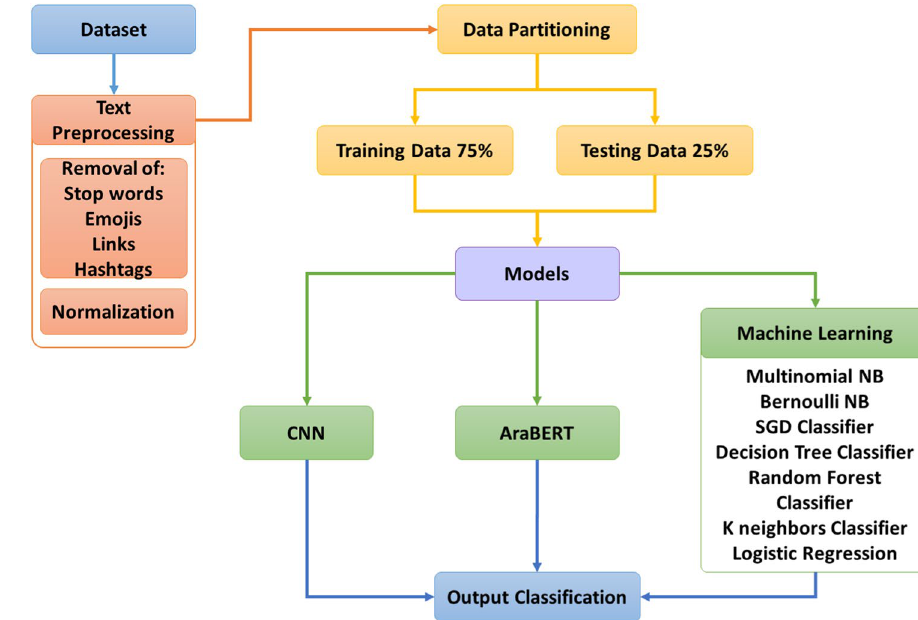
Fig. 5 Abstract diagram of the implementation process